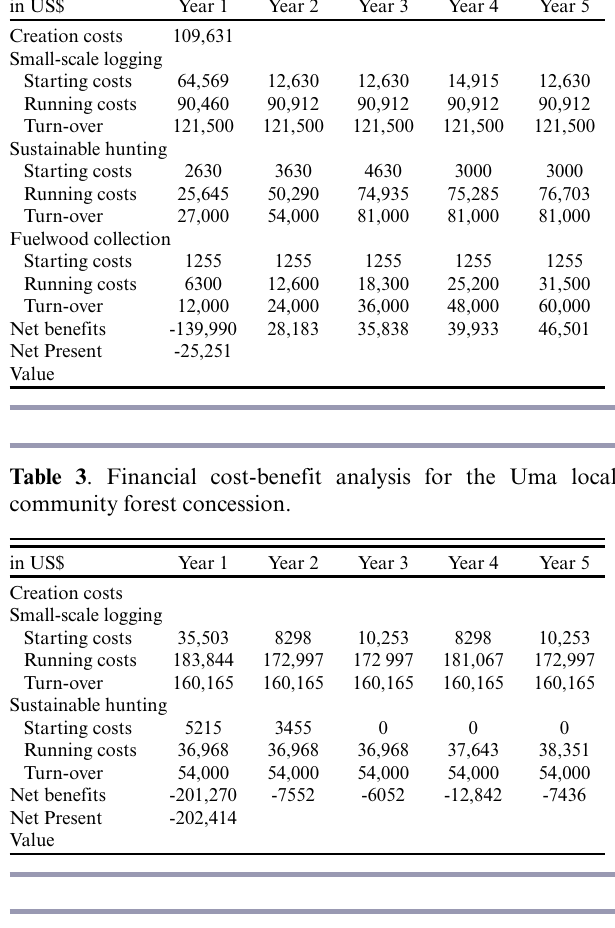
Table 4 . Sensitivity analysis with a change of discount